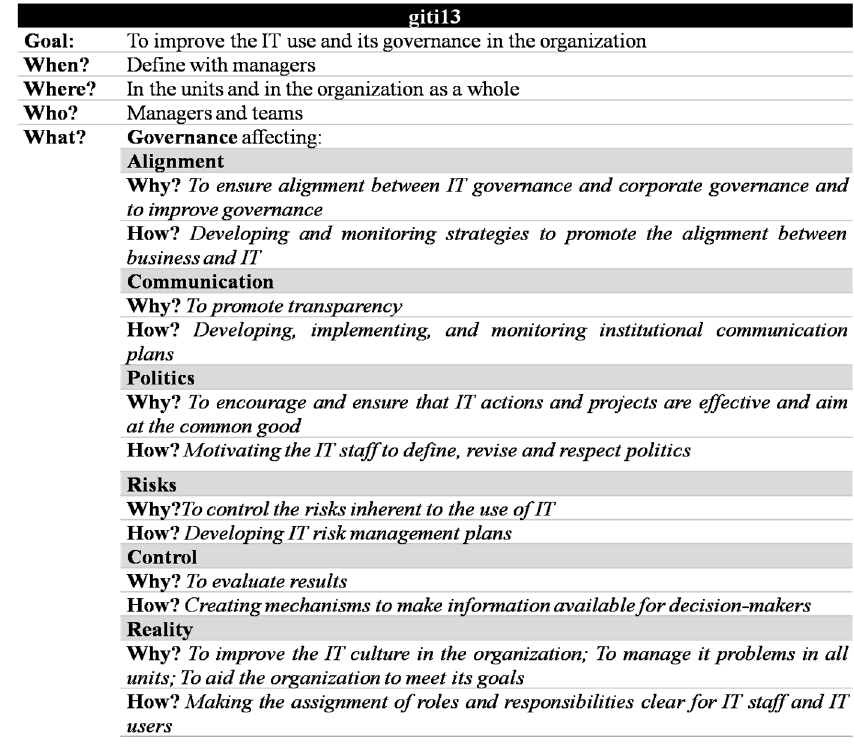
Figure 9. The giti13 Macro Action Plan.